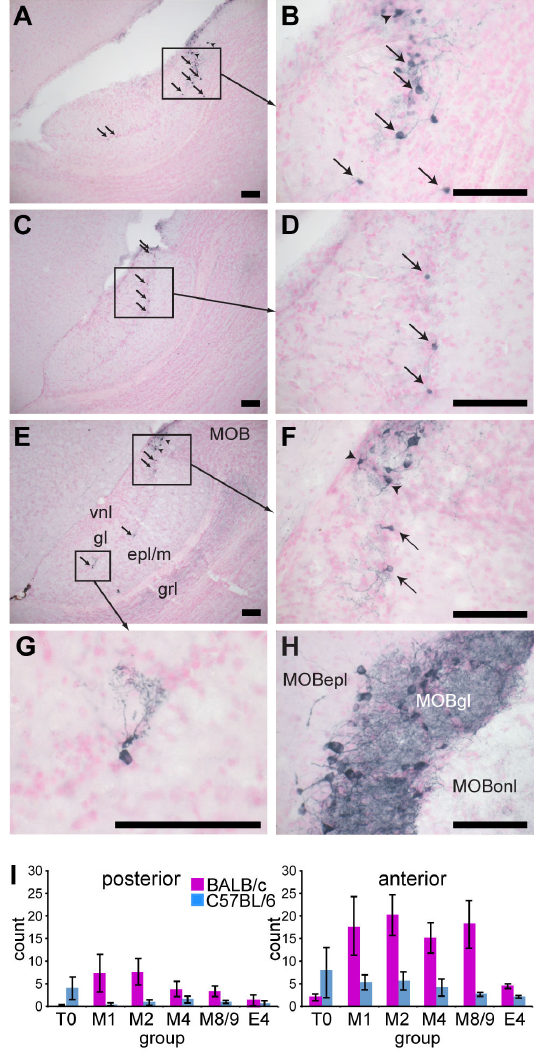
Figure 3. Mating increased the number of TH-positive neurons in the AOB of BALB/c mice. through the AOB of: BALB/c female 2 days following mating (A, B); BALB/c female 9 days following mating (C, D); C57BL/6 female exposed to male bedding (day 0) without mating (E-G). Arrows indicate TH-positive neurons counted within the AOB. Arrowheads indicate TH-positive neurons at the boundary of the AOB that were not counted, despite extending dendrites into the AOB. H) TH-positive neurons were abundant in the main olfactory bulb (MOB). I) Mean (± standard error) number of TH-positive neurons per AOB was increased in mated BALB/c (M1-8/9), but not C57BL/6, females, compared to females without male exposure (T0) and 4 days following exposure to male chemosignals without mating (E4). Scale bars indicate 0.1 mm. AOB structures: vnl, vomeronasal nerve layer; gl, glomerular layer; epl/m, external plexiform/mitral cell layer; grl, granule cell layer. MOB structures: MOBepl, external plexiform layer; MOBgl, glomerular layer; MOBonl, olfactory nerve